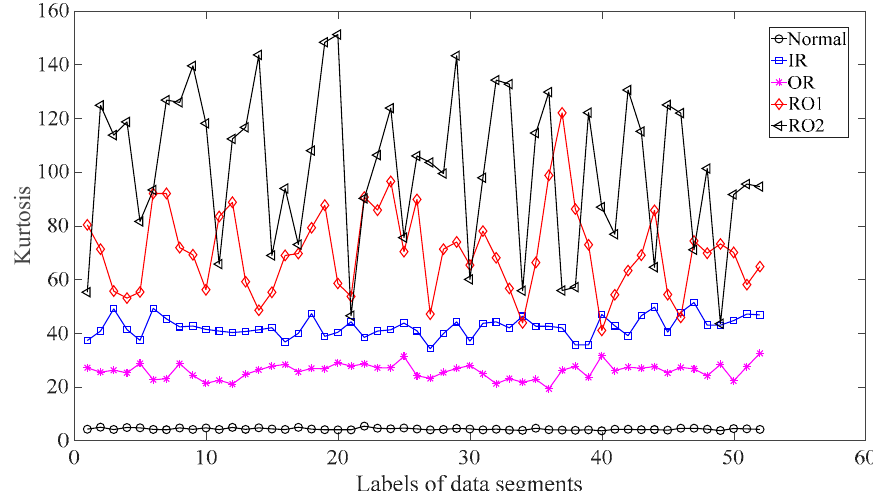
Figure 16. Kurtosis of the five types of roller-bearing vibration data.